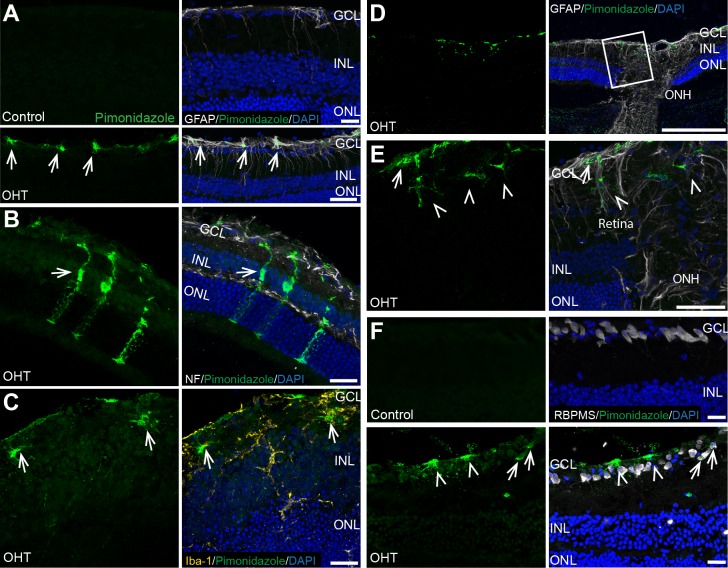
Detection of hypoxic glia and neurons in the retina, 4 weeks after OHT. (A) Sagittal section of control retina with no visible pimonidazole immunolabeling compared with OHT retina showing pimonidazole-positive astrocytes in the NFL, indicated by the arrows. GFAP (astrocyte labeling, white), pimonidazole (green), DAPI (cell nuclei, blue). Retinal layers labeled GCL, INL, and ONL. Scale bar: 25 μm. (B) OHT retina showing pimonidazole-positive Müller glia (arrow). Neurofilament (NF, white), pimonidazole (green), DAPI (cell nuclei, blue). Scale bar: 25 μm. (C) Sagittal section of OHT retina showing pimonidazole-positive microglia (arrows). Ionized calcium binding adaptor molecule 1 (Iba-1, yellow), pimonidazole (green), DAPI (cell nuclei, blue). Scale bar: 25 μm. (D) Sagittal section of OHT retina with visible ON and ONH. ONH shows no pimonidazole (green) adduct accumulation. Scale bar: 250 μm. (E) Inset from (D) sagittal section of OHT retina showing pimonidazole-positive (green) astrocytes (arrow) and microglia (arrowheads). Scale bar: 50 μm. (F) Sagittal section of control retina labeled with RBPMS (white) showing absence of hypoxia compared with OHT retina showing pimonidazole-positive RGCs (arrows) and astrocytes (arrowheads). RBPMS (RGC labeling, white), pimonidazole (hypoxia detection, green), and DAPI (blue). Scale bar: 20 μm, n = 10 independent OHT eyes and 8 independent control eyes.